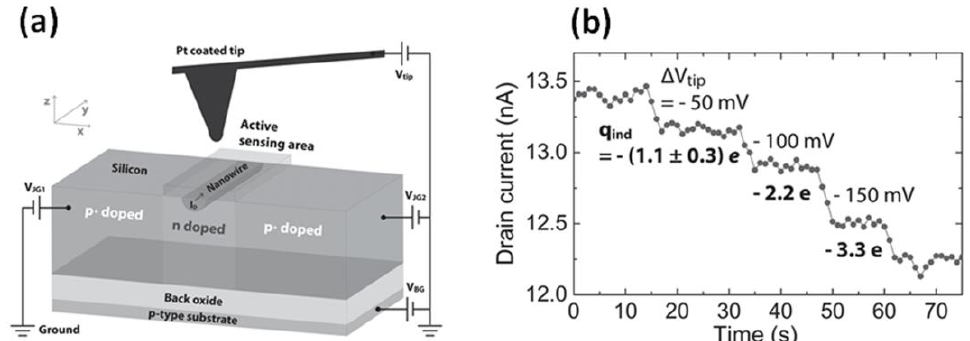
Figure 5. Limit of detection (LOD) of an EFN gas sensor. ( a ) Schematic illustration of the scanning gate microscopy methodology; ( b ) an I DS vs time curve, in which the small steps in I DS are due to the induced atomic force microscopy (AFM) tip charge, which sets the EFN gas sensor electrostatic LOD (eLOD) to the range of a single elementary charge. Reprinted from [41], with permission from Wiley Publishing.